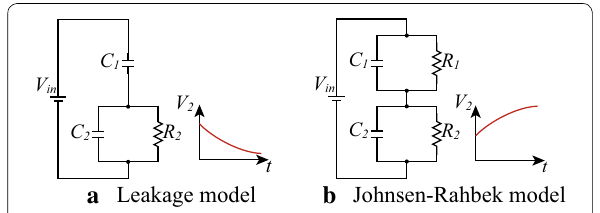
Fig. 1 Equivalent circuits for leakage and Johnsen–Rahbek